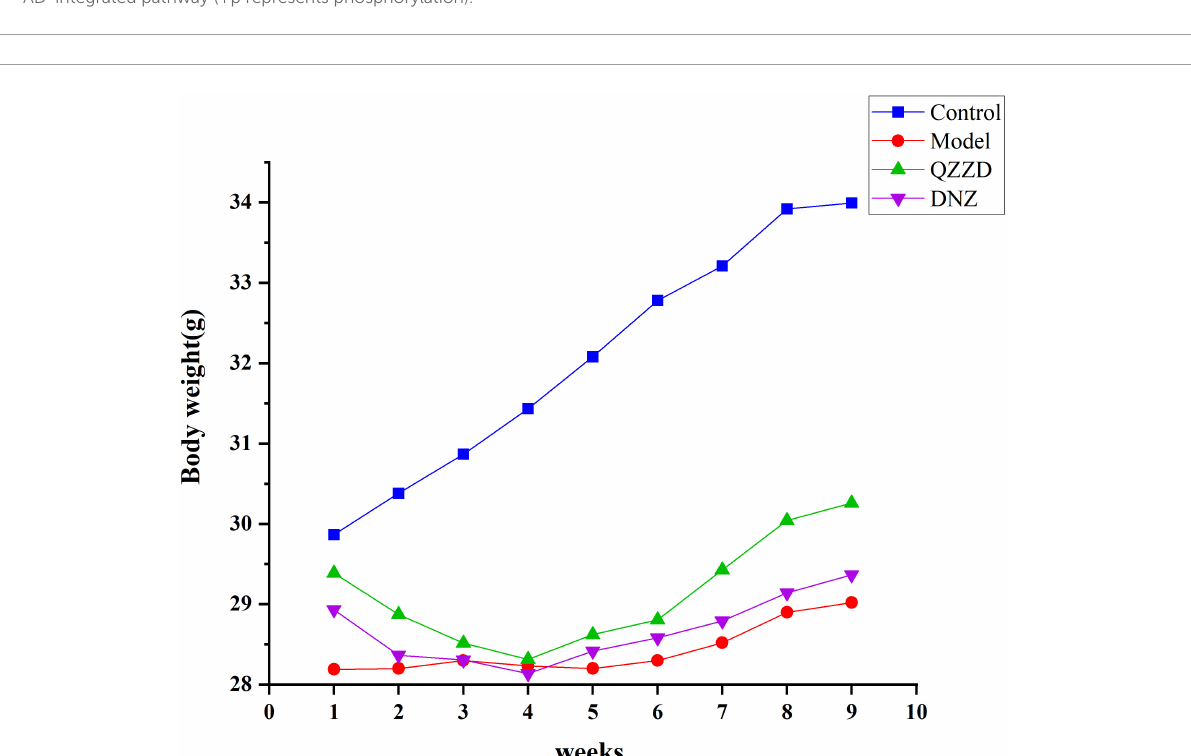
FIGURE8 Weight change of mice in different groups. Values are expressed as mean ± SD, n = 12 in each